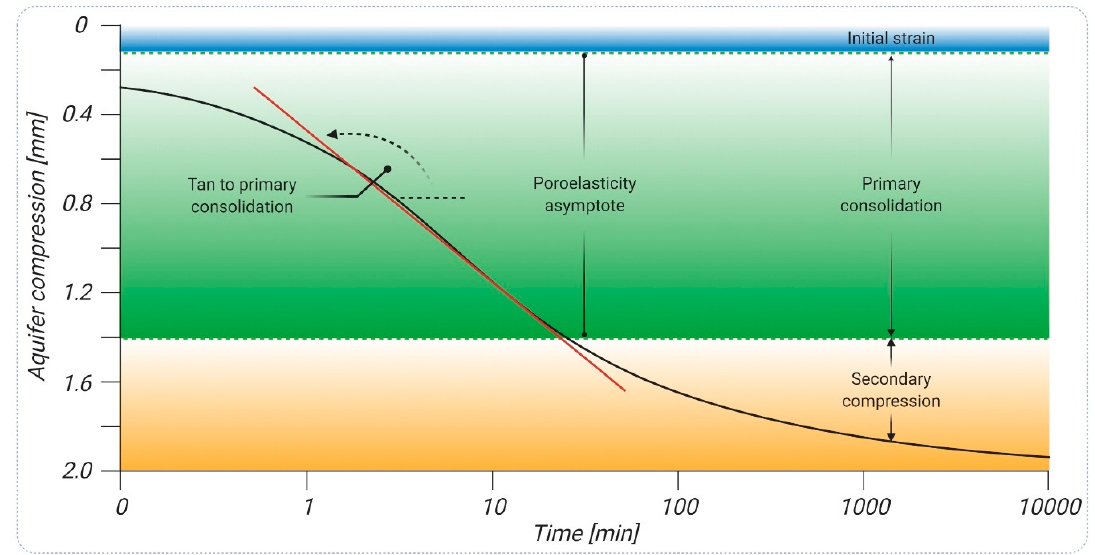
Figure 7. 1-D consolidation test curve showing three independent physical processes—instantaneous strain (initial), primary consolidation (intermediate time) and secondary compression time (late time); modified after [148].